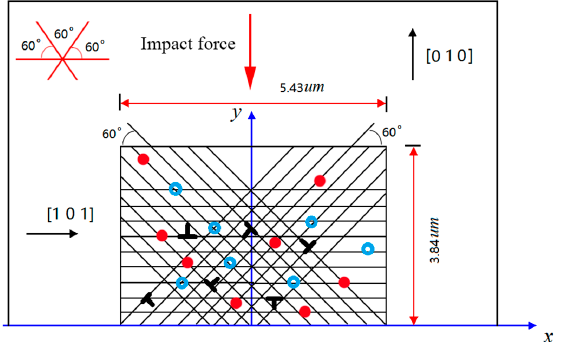
Figure 7. The periodical monocrystalline silicon model. The mesoscale material model consists of dislocation sources (solid circles), obstacle sources (open circles), pre-existing dislocations, and slip system.